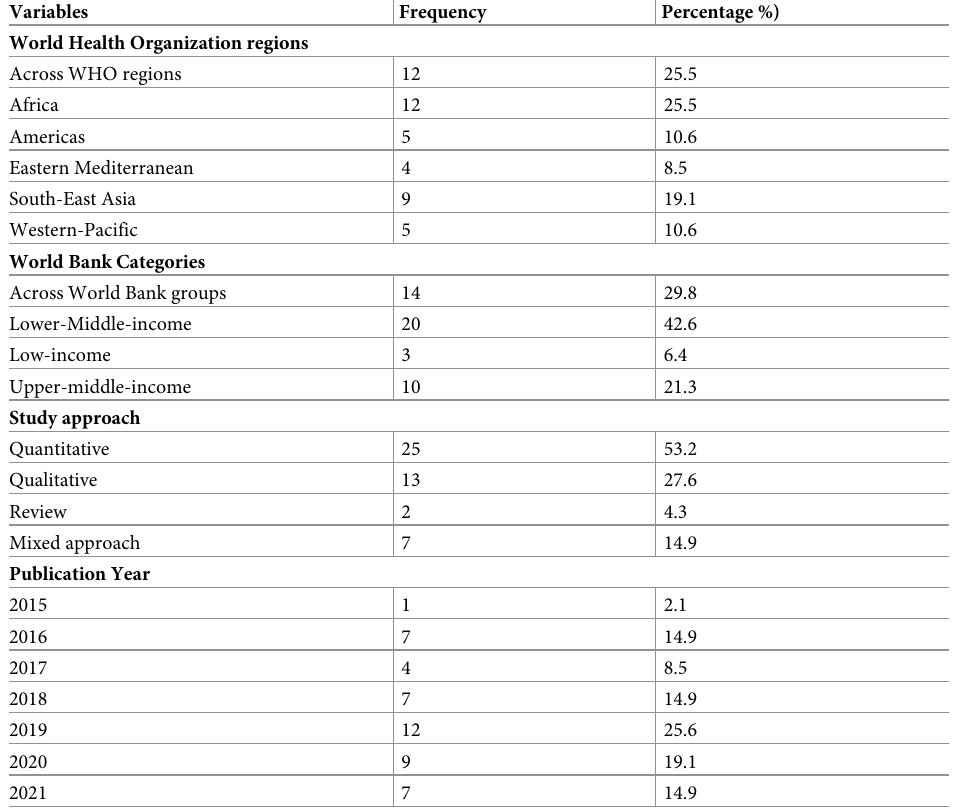
Table 1. Articles distributions by World Health Organization region and World Bank category, study approach, and year (n = 47).